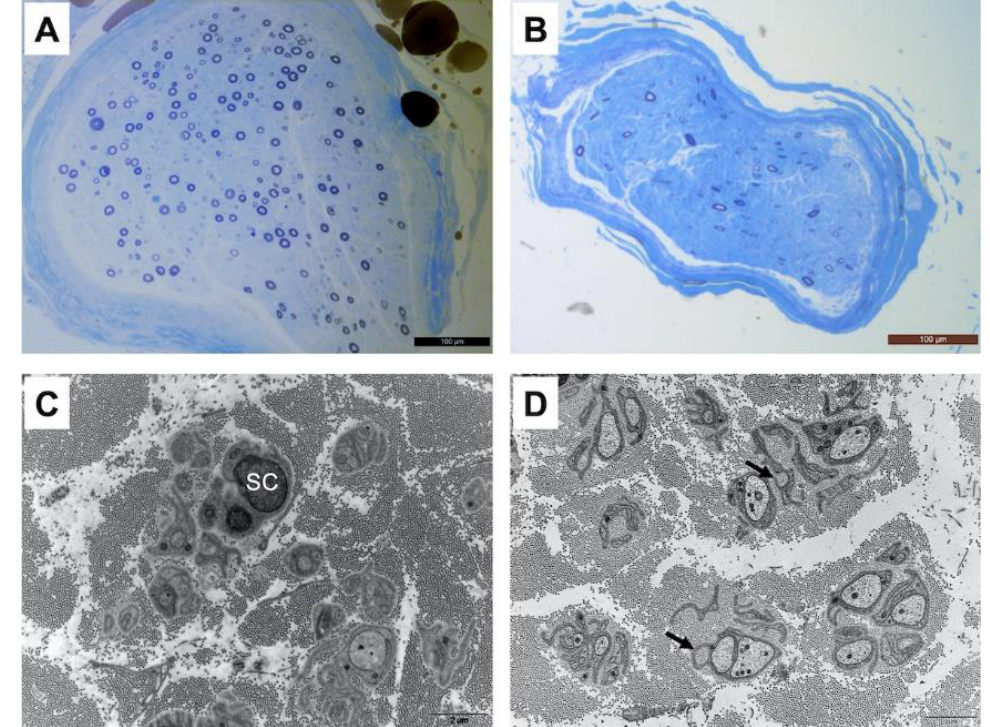
Figure 1. Moderate to severe loss of large and small diameter myelinated fibers in the radial nerve of patient 1 ( A ) and in the sural nerve of patient 3 ( B ) Resin-embedded semi-thin transverse sections stained with toluidine blue. On electron microscopic examination, small fibers around a Schwann cell (SC) are largely disorganized with several extensions and occasional stacks of membranes in the radial nerve of patient 1 ( C ). The same pattern is observed in the sural nerve of patient 3 ( D ) with the presence of dispersed collagen pockets (arrows). Transverse ultrathin sections of radial and sural nerves stained with uranyl acetate and observed under an electron microscope (scale bar 2um for C and D).